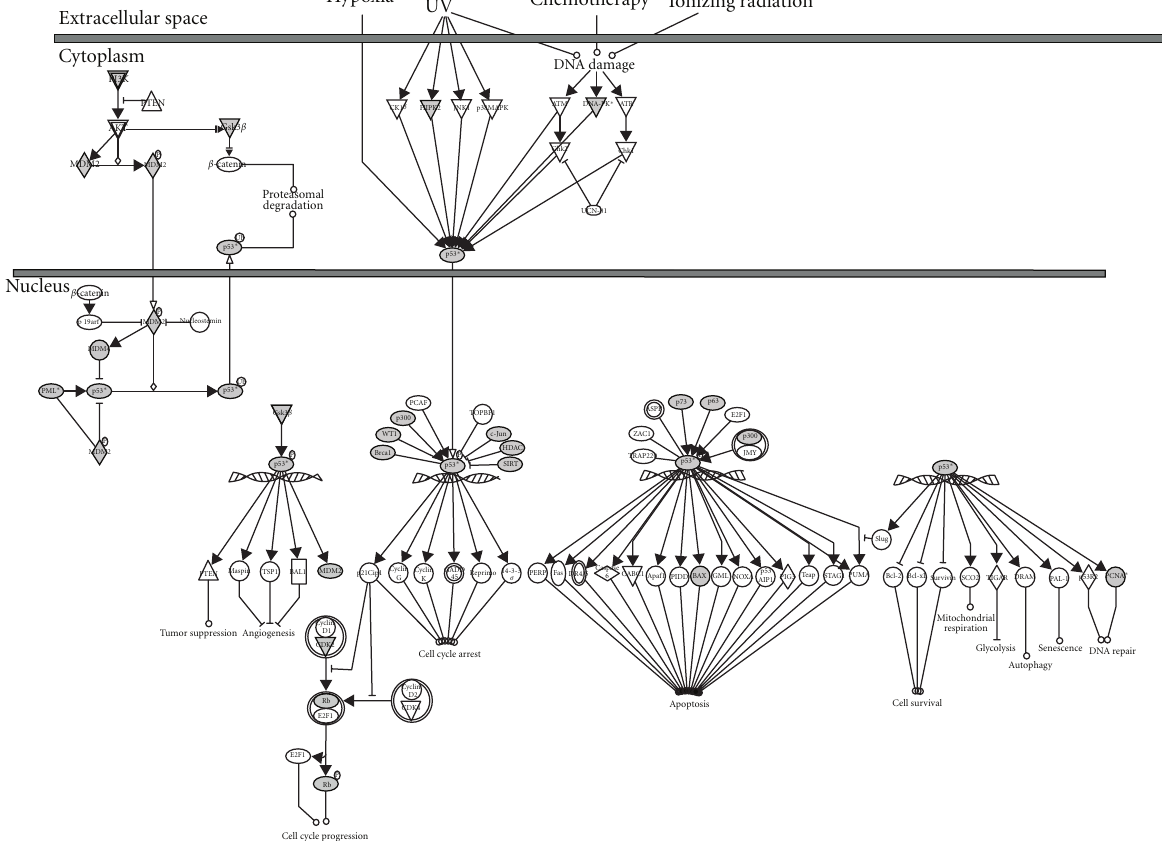
Figure 6: Integrated view of the role of SUMO in the p53 Signalling pathway. Ingenuity analysis of proteins that have been identified (in gray) in recent studies: TP53, WT1, PRKDC, TP63, PIK3C2A, TP73, HDAC1, MDM2, BAX, EP300, RB1, PCNA, MDM4, JUN, GSK3B, HIPK2, PML, BRCA1, CDK2, and SIRT1 (Figure 4 and Supplementary Table 1) by mass spectrometry using